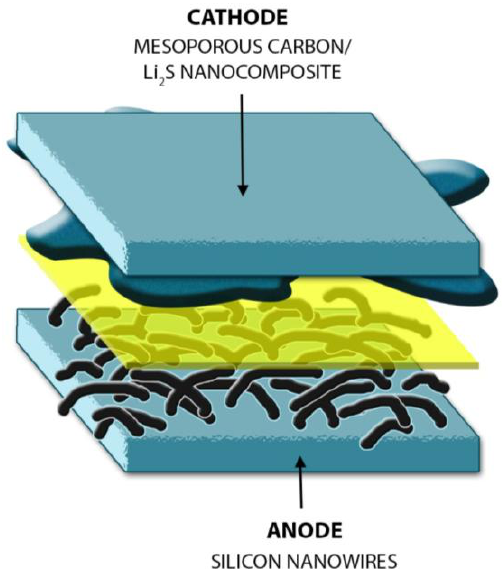
Figure 4. Lithium Sulfur battery schematic. The chemical reaction for the L–S battery is